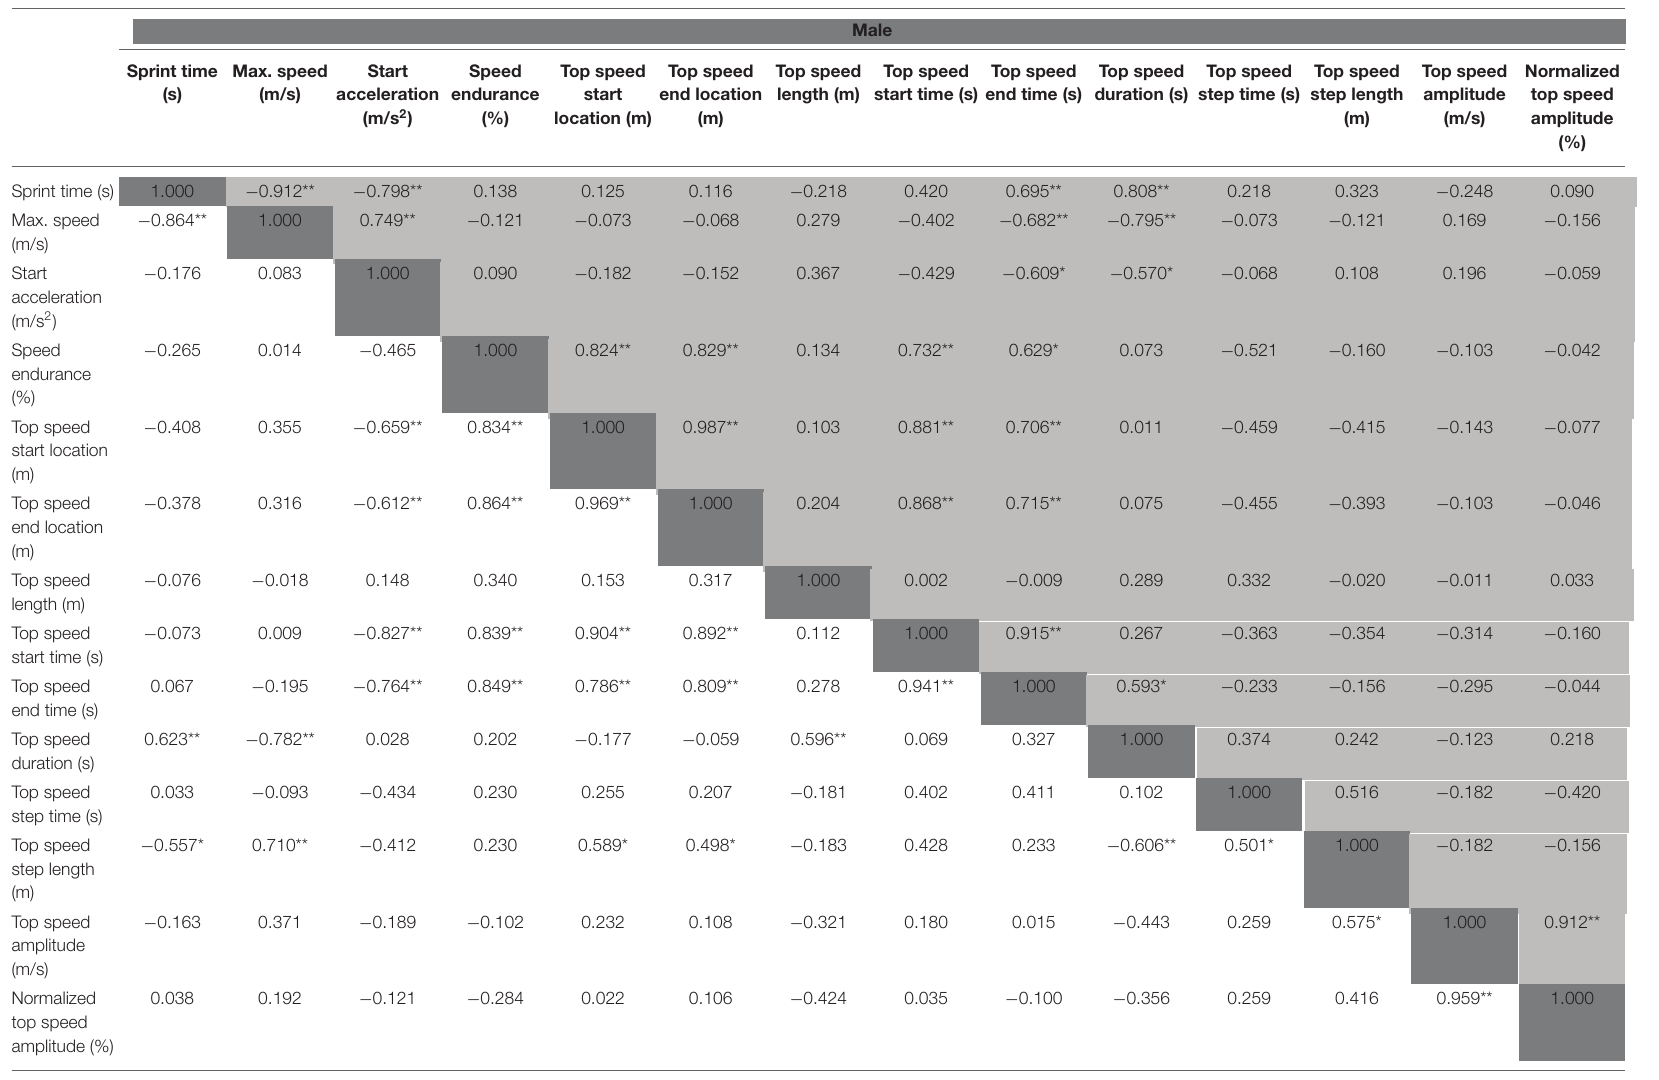
TABLE 4 | Correlation Matrix separately for male (lower triangular matrix, white) and females (upper triangular matrix,